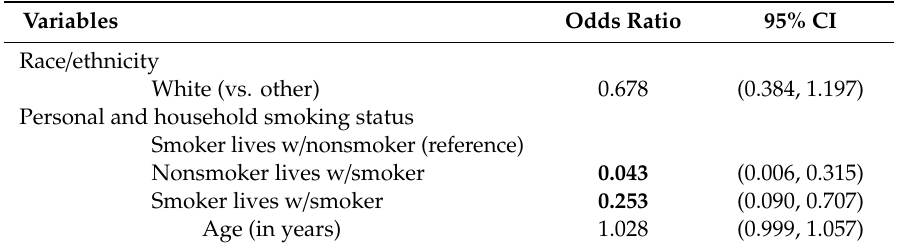
Table 3. Logistic Regressions Predicting Call Response for Direct Mail